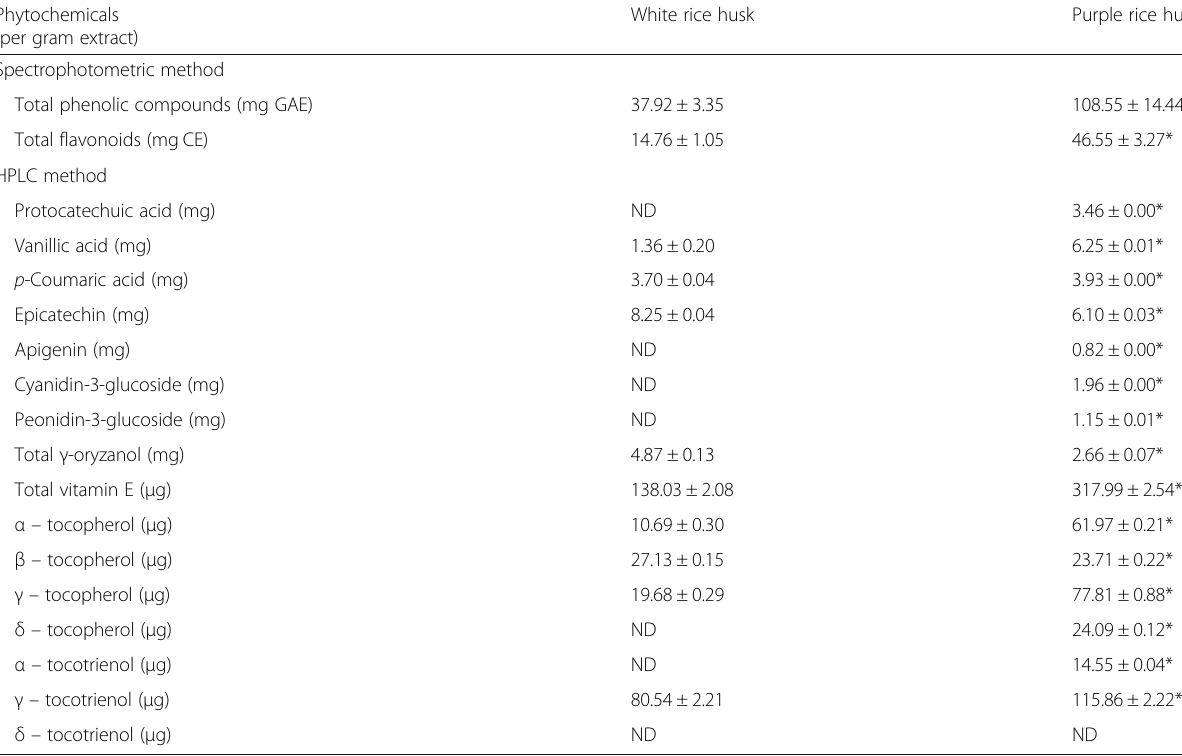
Table 1 Chemical constituents in methanol extracts of rice husk Phytochemicals (per gram